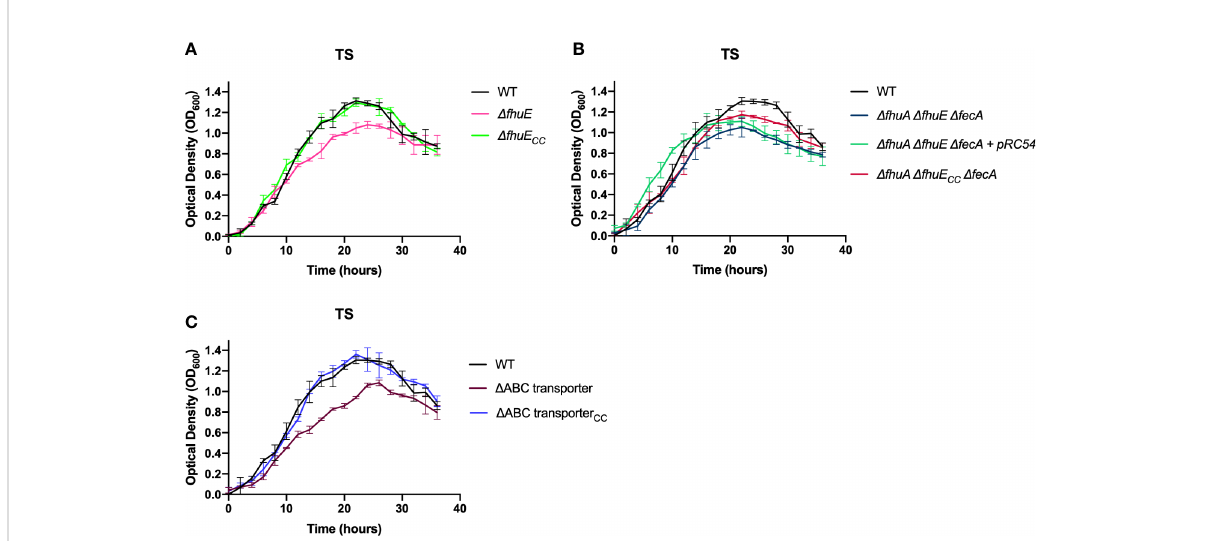
FIGURE 3 Growth of F.columnare wild type, outer membrane receptor deletion mutants, ABC transporter deletion mutant, and complemented mutants in iron-limited (TS) medium. (A) Wild type (WT), D fhuE , and D fhuE mutant complemented by inserting fhuE back into the chromosome. “ CC ” indicates chromosomal complementation. Signi fi cant differences in peak cell density were seen between the WT and D fhuE (P < 0.0001). (B) WT, D fhuA D fhuE D fecA mutant, D fhuA D fhuE D fecA mutant complemented with plasmid pRC54 (expresses fhuE ), and D fhuA D fhuE D fecA mutant complemented by inserting fhuE back into the chromosome. Signi fi cant differences in peak cell density were seen between the WT and D fhuA D fhuE D fecA (P < 0.0001), WT and both complemented strains (P < 0.05), and D fhuA D fhuE D fecA and both complemented strains (P < 0.05). (C) WT, D ABC transporter mutant, D ABC transporter mutant complemented with plasmid pRC47 (expresses the ABC iron transporter genes), and D ABC transporter mutant complemented by inserting the ABC transporter genes back into the chromosome. Signi fi cant differences in peak cell density were seen between the WT and D ABC transporter mutant (P < 0.0001). Strains were grown at 28°C with shaking (200 rpm) and measurements were taken every two hours for 36 hours. Error bars represent standard error of the